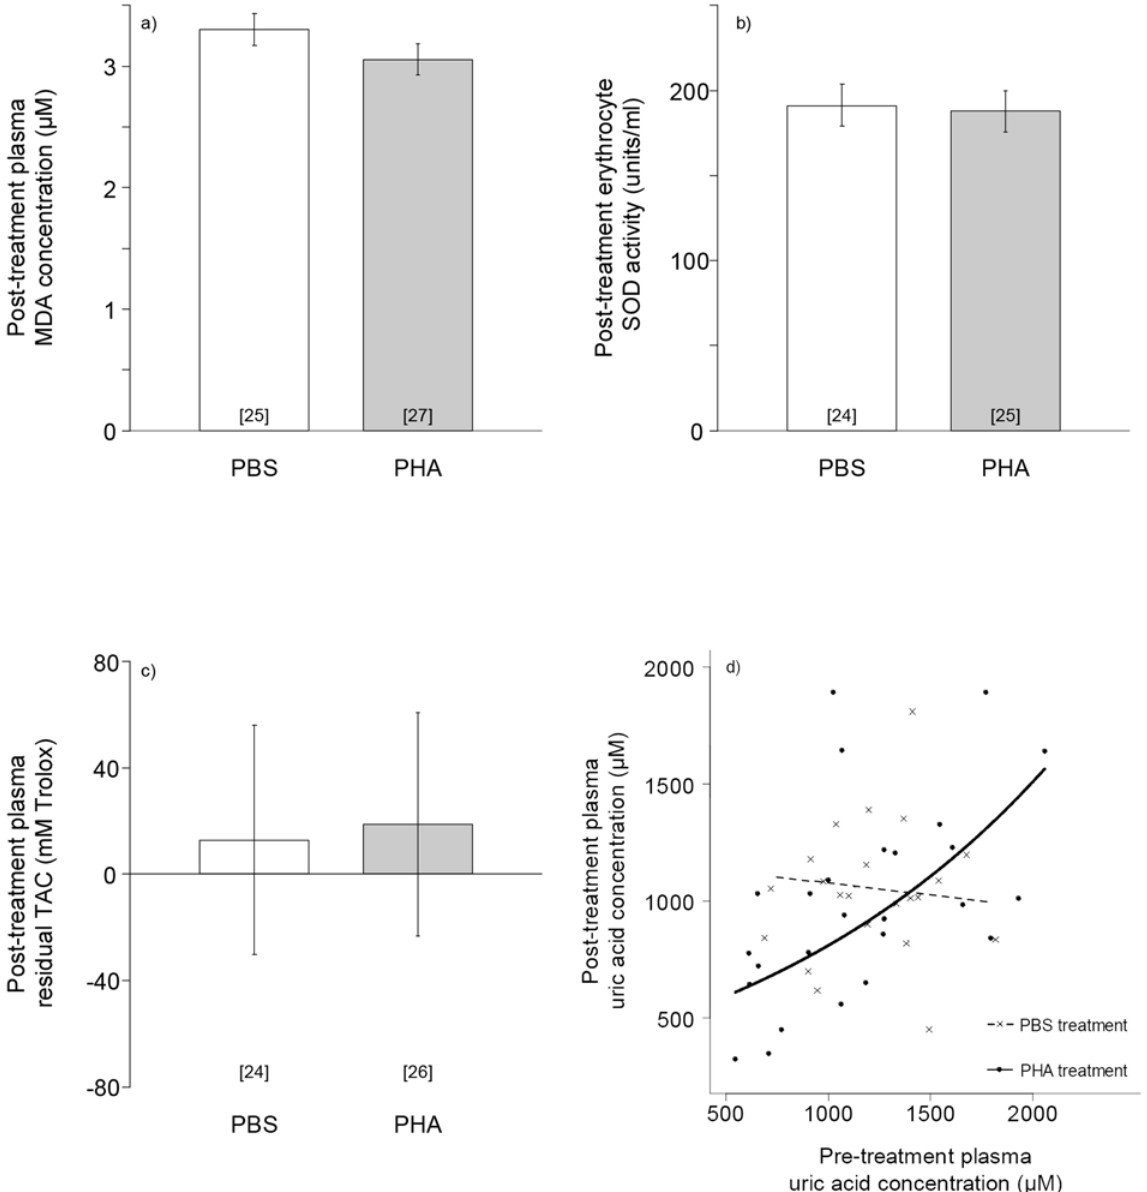
Fig 1. The effect of PHA immune activation on measures of oxidative status. Relative to PBS-injected controls, PHA challenge had no significant effect on: (a) plasma concentrations of maldondialdehyde (MDA); ( b) the activity of the antioxidant enzyme superoxide dismutase in erythrocytes (SOD); (c) plasma total antioxidant capacity excluding the effects of uric acid (residual TAC). ( d) Post-injection plasma uric acid concentrations were predicted by a signficiant interaction between treatment and baseline plasma uric acid concentrations. In (a), (b) and (c), bars show model predictions ± S.E. from linear mixed models with treatment as the only predictor. Numbers in parentheses denote sample sizes. In (d), circles are PHA birds, crosses are PBS control birds. Lines represent model predictions for PHA (solid line) and PBS-injected birds (dashed line) from a linear mixed model containing the interaction of treatment and pre-treatment uric acid levels. (slope ± S.E.: +1.02 ± 0.07), but post-treatment SOD was typically lower than pre-treatment SOD in males (slope ± S.E.: 0.83 ± 0.05). There was also no significant effect of treatment on = 0.03, p = 0.87, n = 50 birds), nor were there significant ef- plasma residual TAC (Fig. 1c, χ 2 1 < 2.25, p > 0.13). There was, however, fects of pre-treatment residual TAC or sex (both χ 2 1